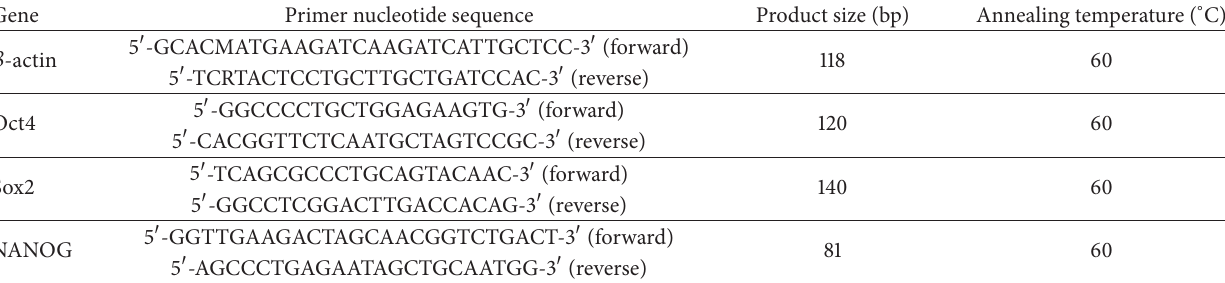
Table 1: Primer sequences and conditions for real time reverse transcription polymerase chain